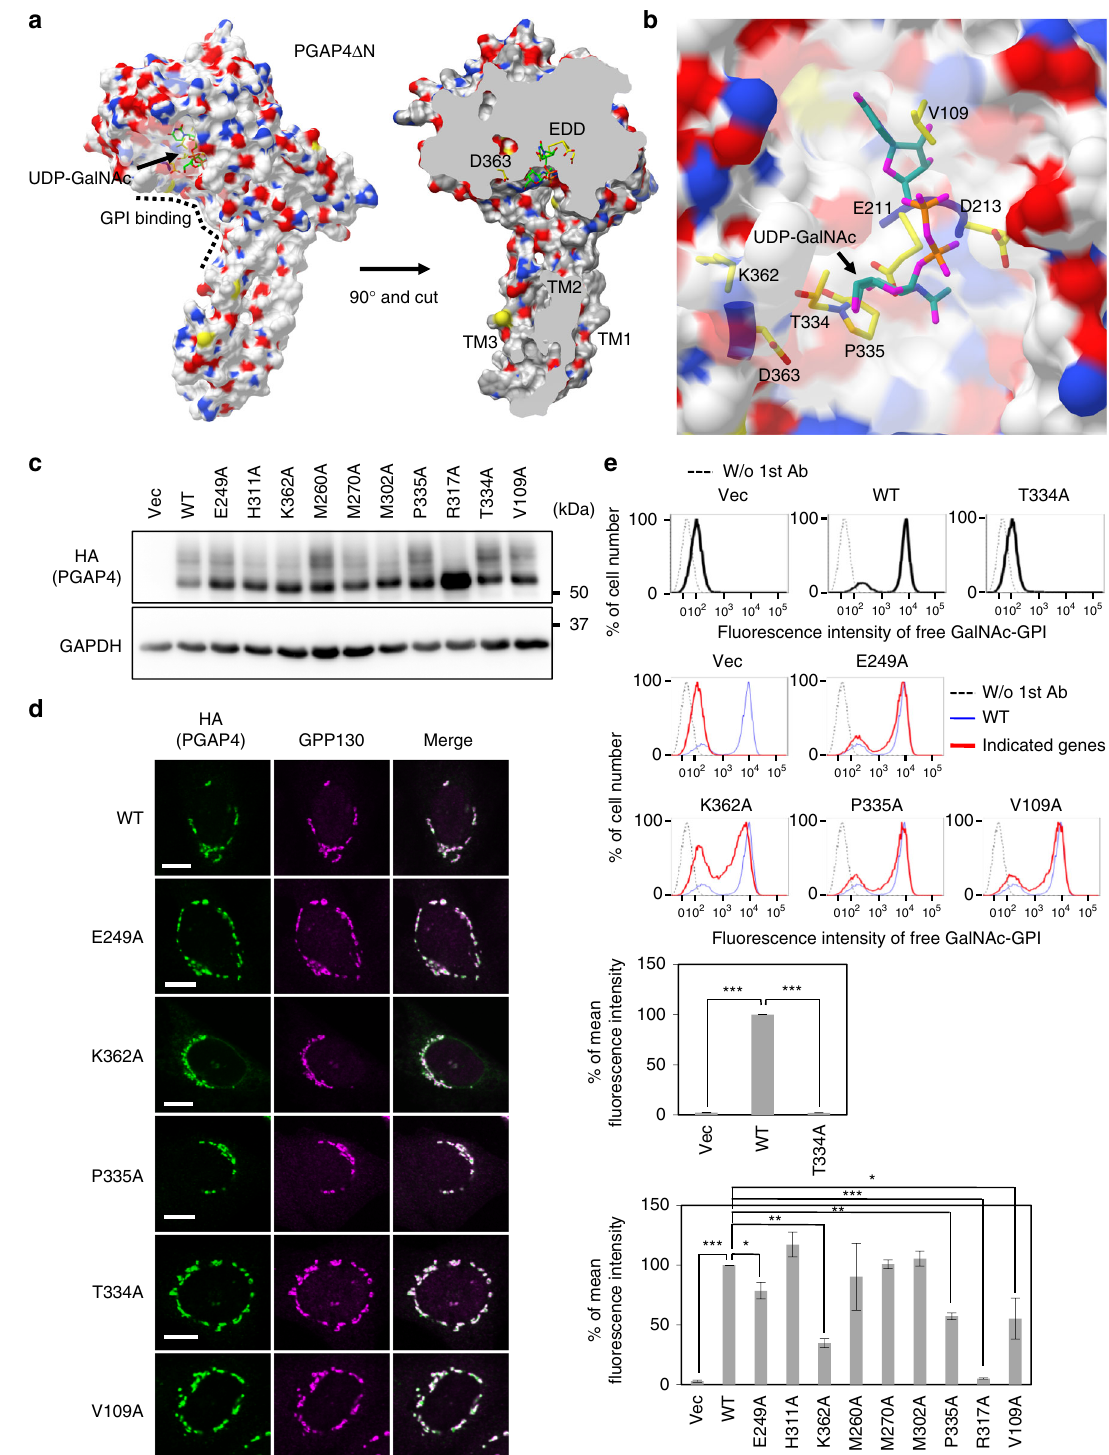
change in the expression of GPI-APs (Fig. 7f). However, mass spectrometry of protein-bound GPI showed a smaller difference in the ef fi ciency of GalNAc modi fi cation (93.5% [WT] vs. 86.2% strictly recognized by